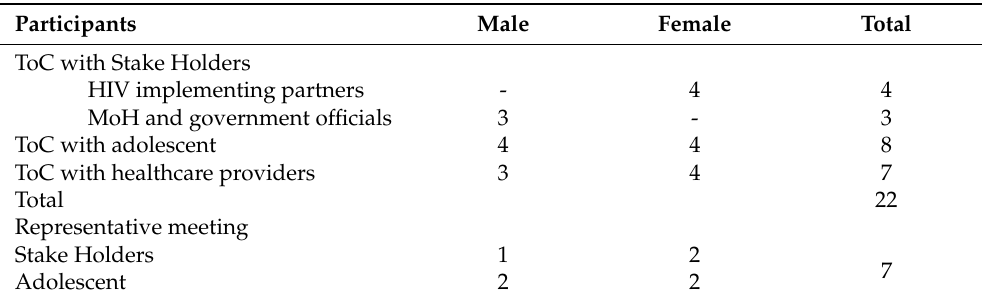
Table 1. Description of study